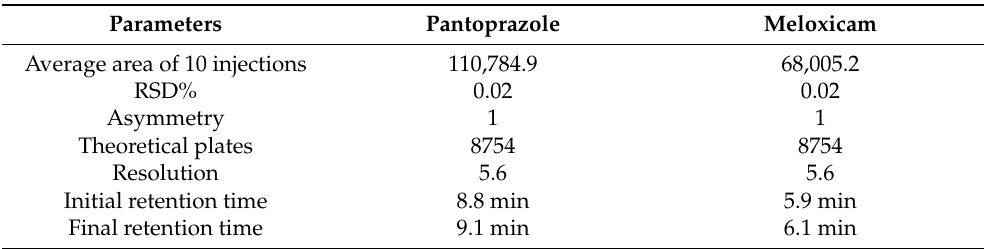
Table 3. System parameters for simultaneous measurements of diluent-containing meloxicam and